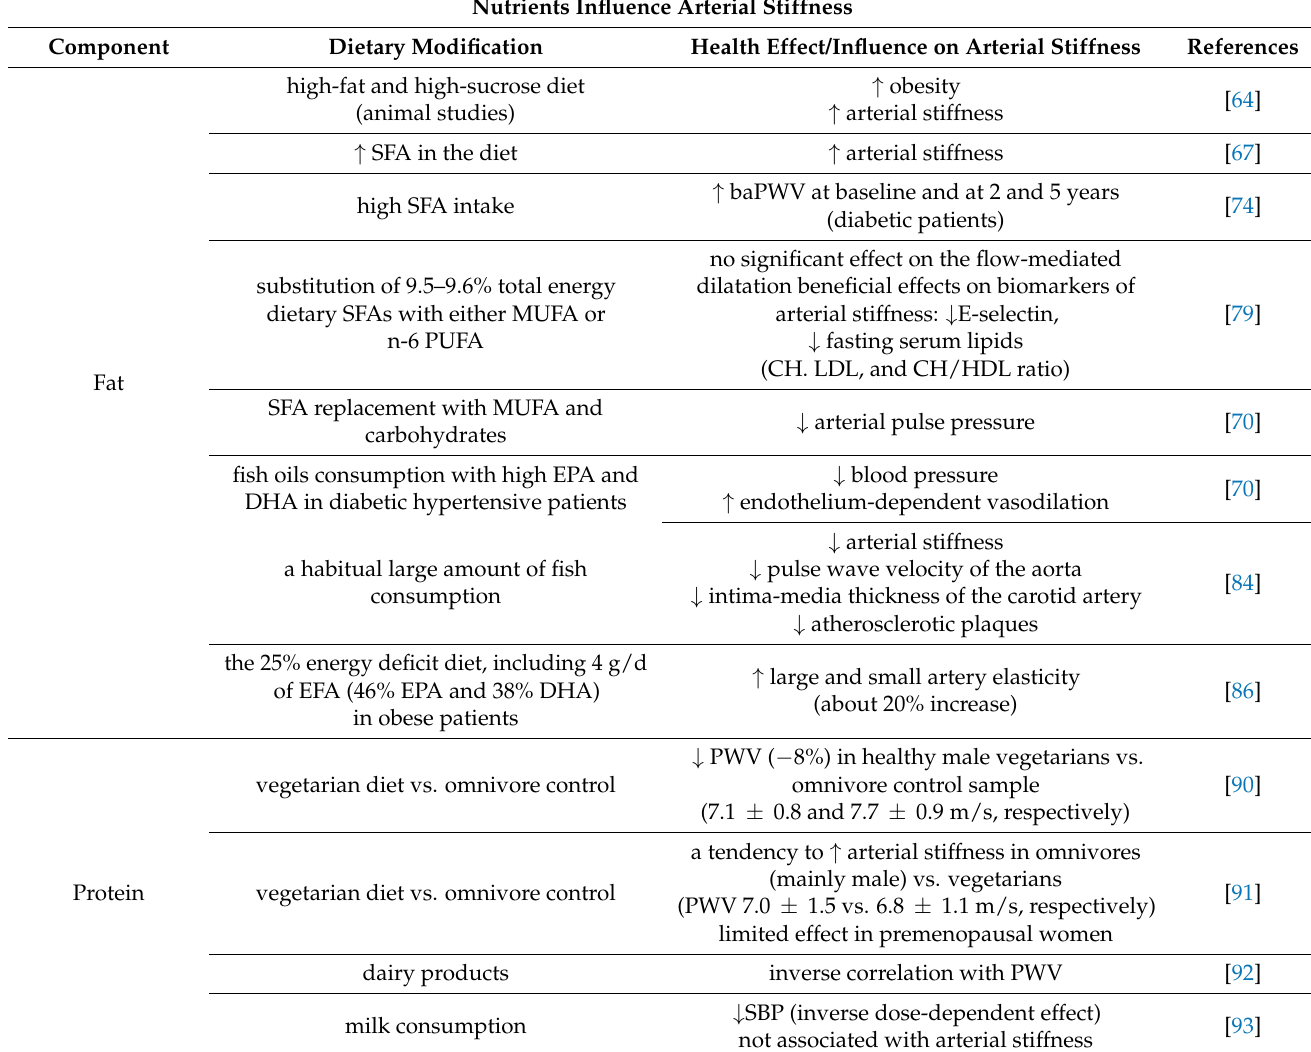
Table 1. Dietary effect of various nutrients on arterial stiffness and cardiovascular